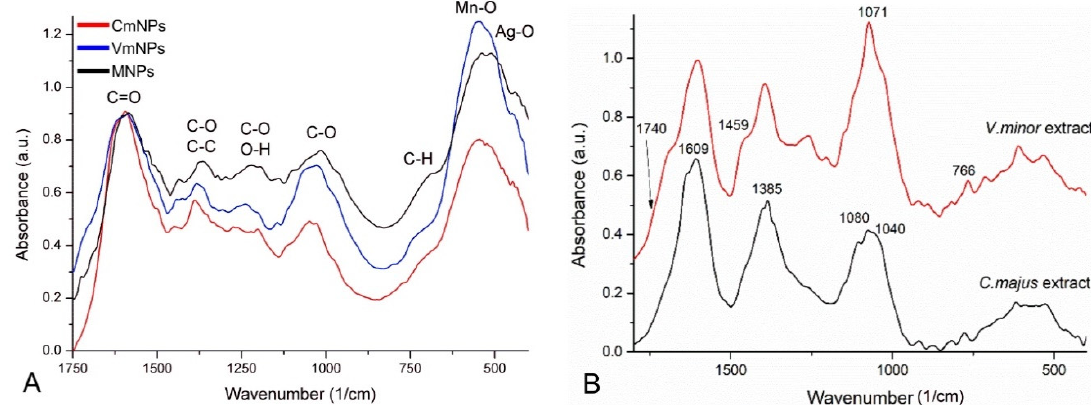
Figure 5. FTIR spectra showing the characteristic stretching vibration bands of the obtained Ag-MnO 2 NPs ( A ), and of the plant extracts ( B ) used for this study.